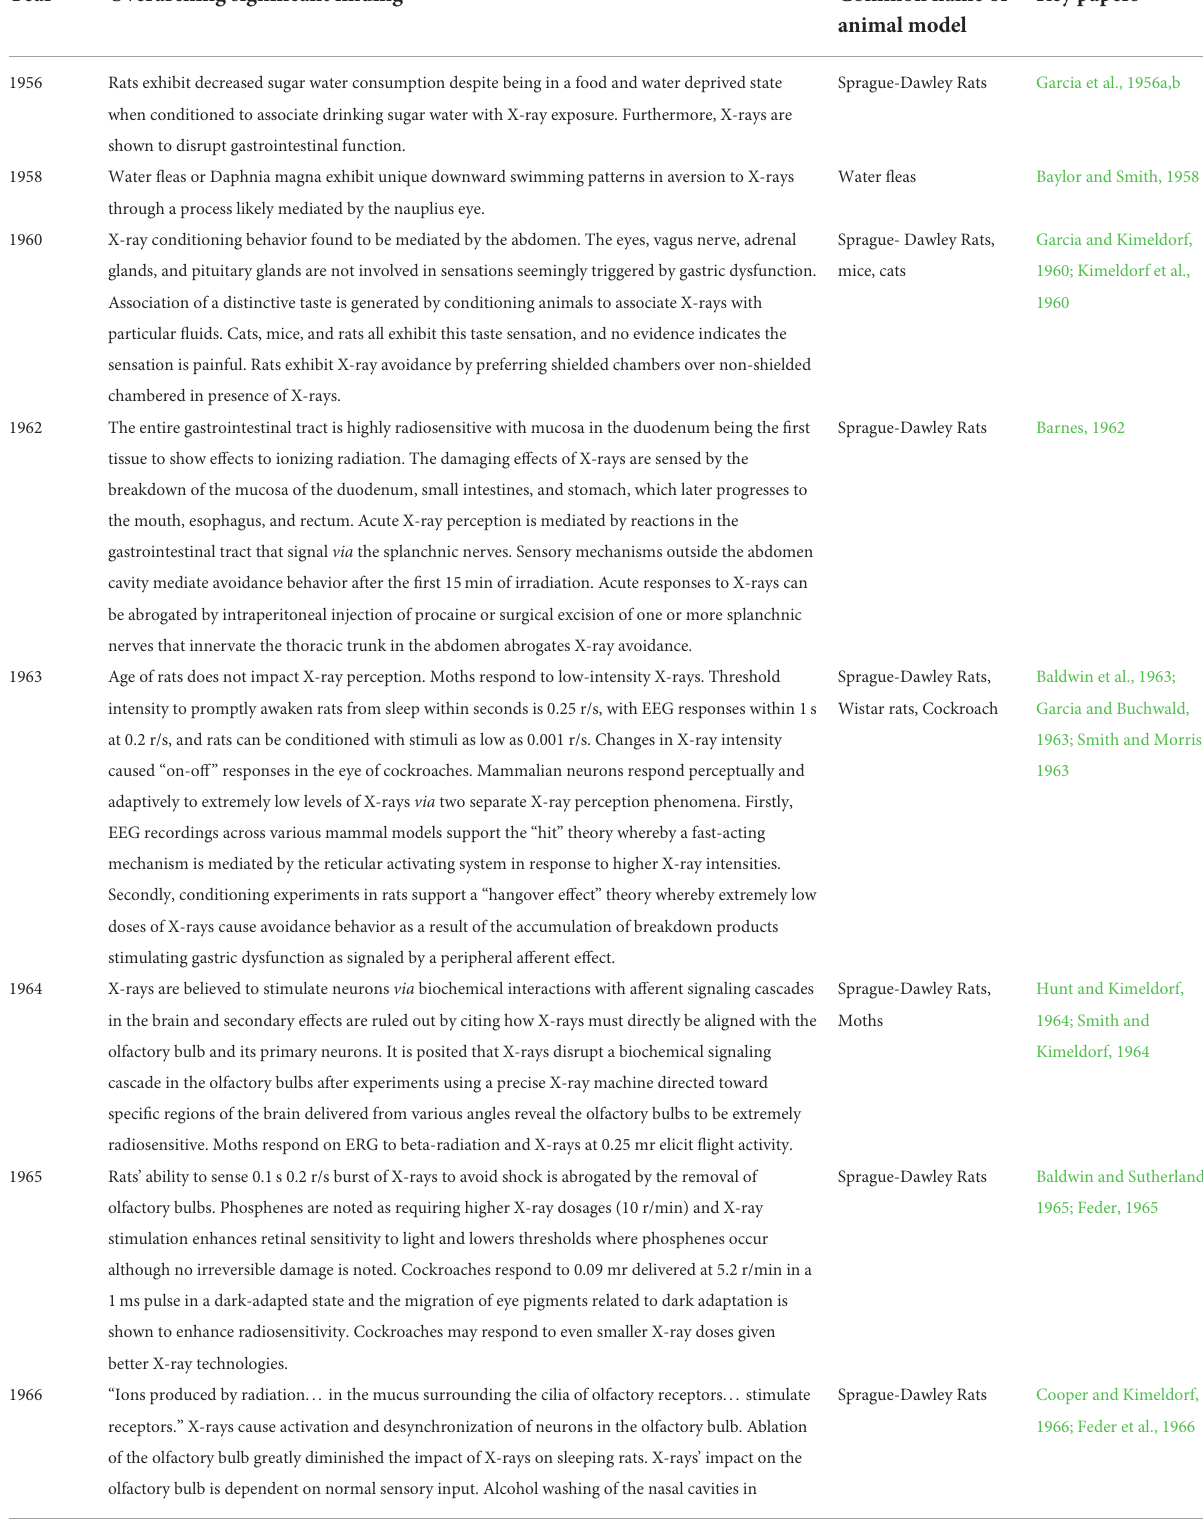
TABLE 2 Significant findings from animal studies of X-ray perception from 1956 to 1993 by Period.